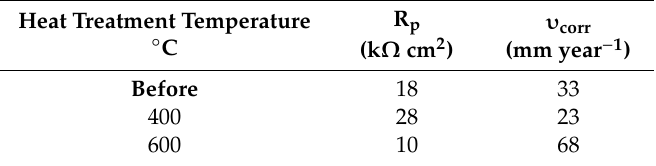
Table 4. Polarization resistance and corrosion rate of the Al / Cu alloy on the Al